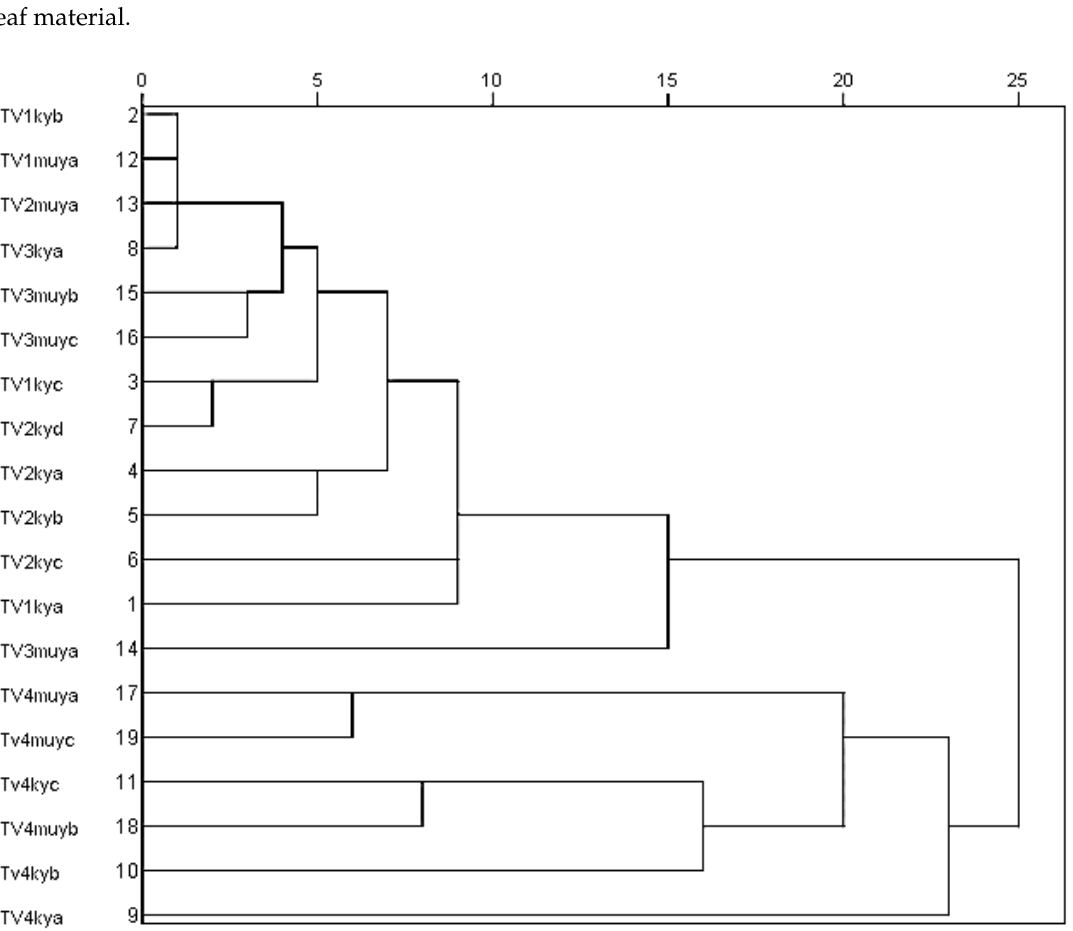
Figure 5. Compounds of chemotaxonomic significance identified from T. vogelii.